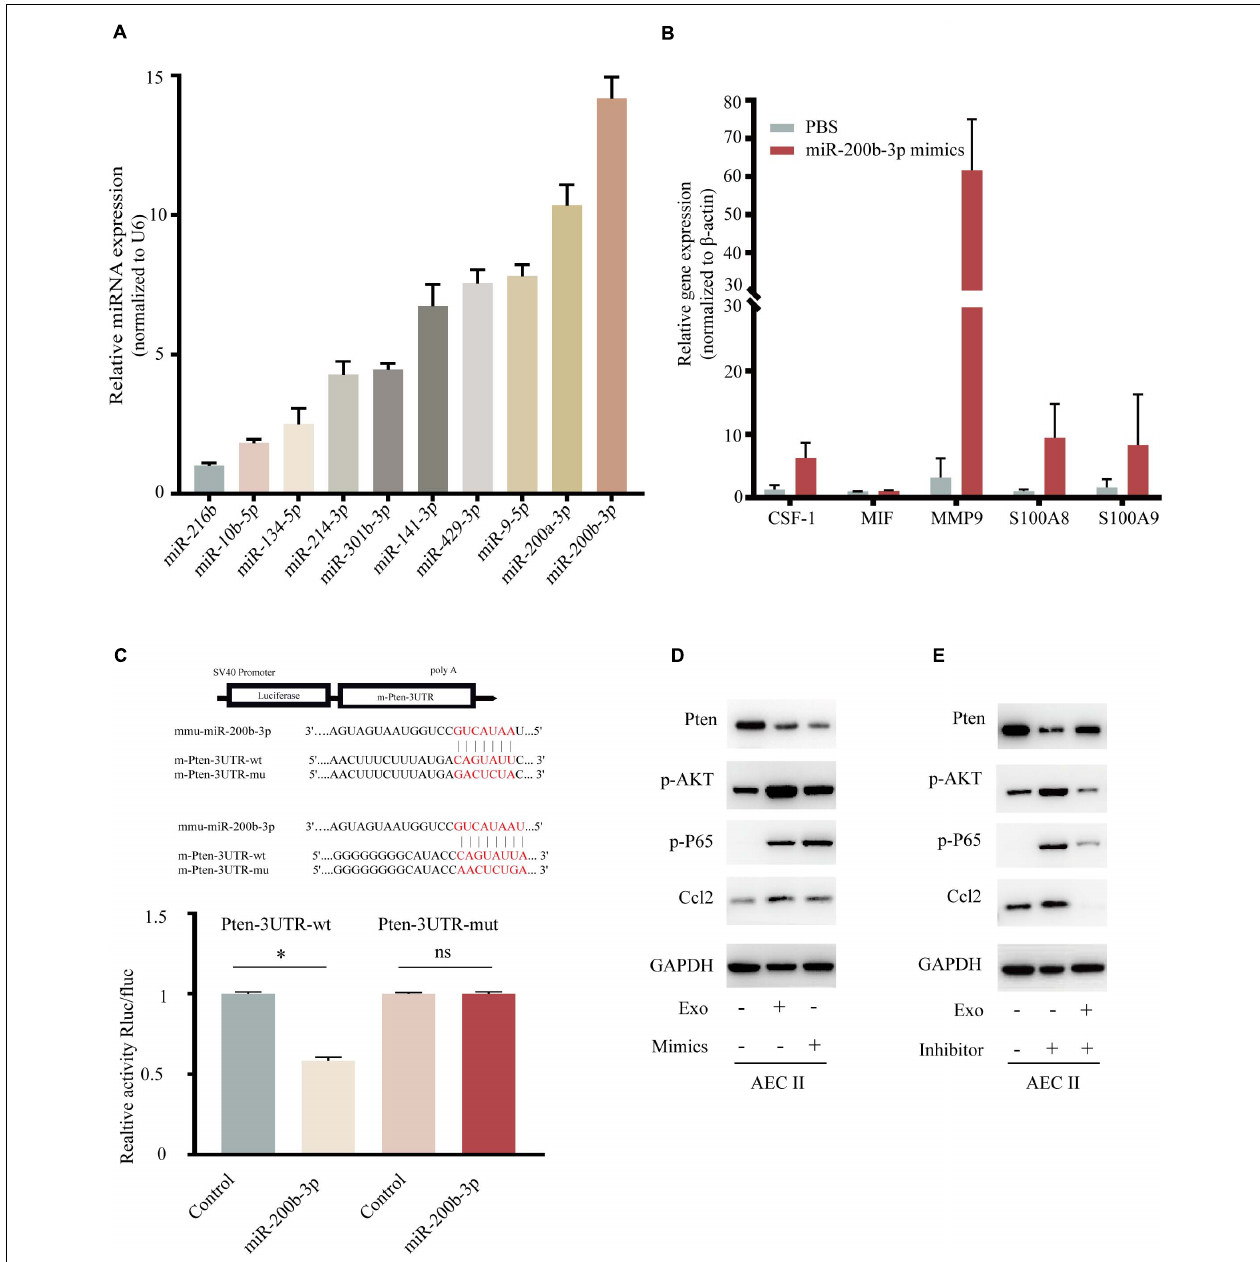
FIGURE 5 | Exosomal miR-200b-3p directly targets PTEN to regulate CCL2 expression. (A) Relative expression of miRNA in 4T1 derived exosomes. (B) mRNA expression of niche formation associated gene in AEC II treated with indicated treatments. (C) Dual-luciferase reporter assays showed that miR-200b-3p significantly decreases the relative luciferase activity of the wild-type PTEN luciferase plasmid compared with the mutant. (D) Western bolt was performed to detect protein levels of PTEN , p-AKT, p-P65, and CCL2 in AEC II co-transfected with 4T1-Exo or miR-200b-3p mimics. (E) Western bolt was performed to detect protein levels of PTEN , p-AKT, p-P65, and CCL2 in exosome-trained AEC II co-transfected with miR-200b-3p inhibitors. P values were calculated by unpaired Student’s t -test (* P <